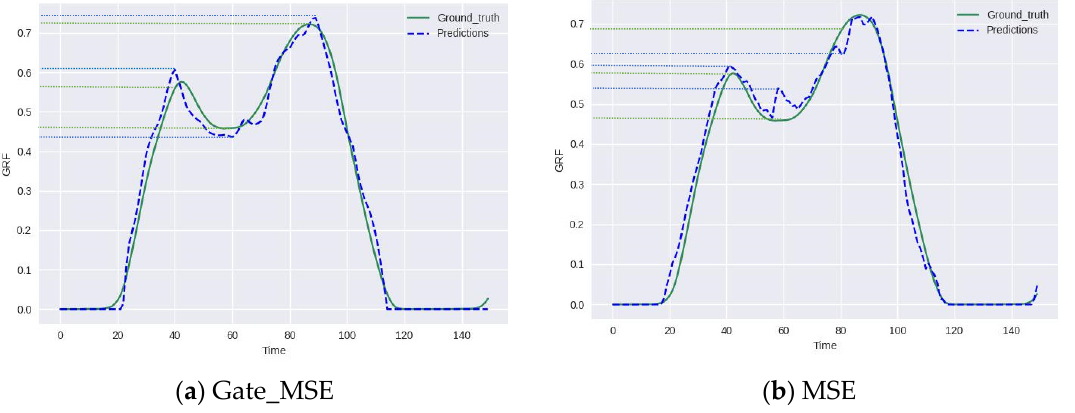
Figure 5. We compare the effect of using ( a ) Gate_MSE and ( b ) MSE on the output results. From the figure, we can see that Gate_MSE has better results on peak prediction.